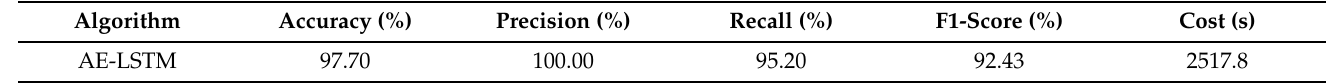
Table 3. Evaluation metrics values for the LSTM-Autoencoder